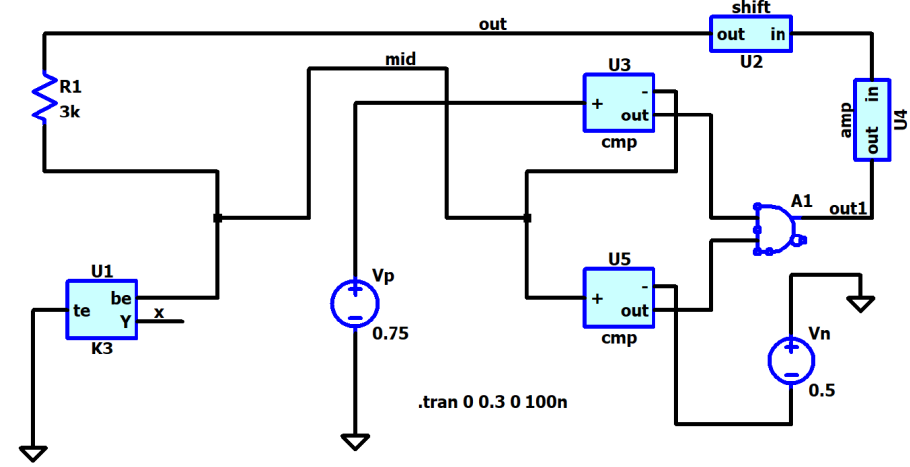
Figure 12. A memristor-based reactance-less generator.